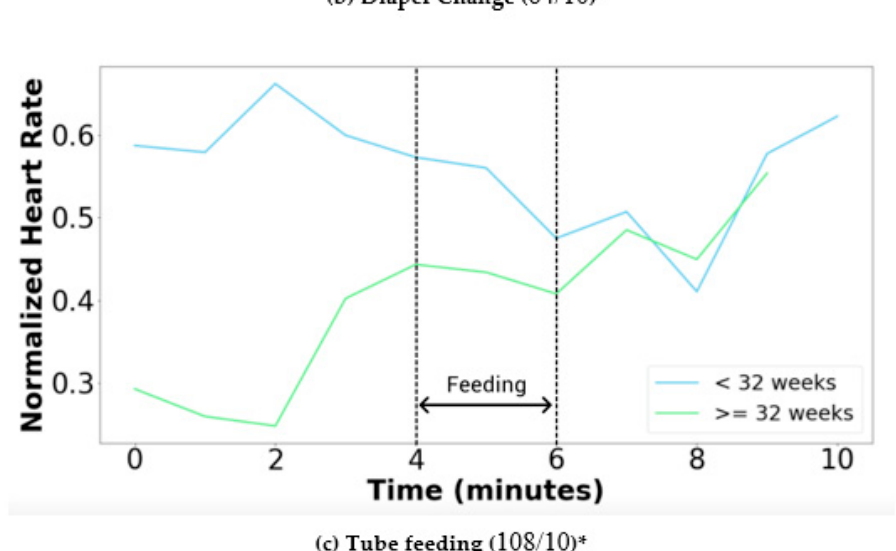
Figure 8. Variability in physiological signals captured every minute (average values) during the manipulations in the clinical setting. ( a ) patting, ( b ) diaper change, and ( c ) tube feeding. * number of manipulations/number of